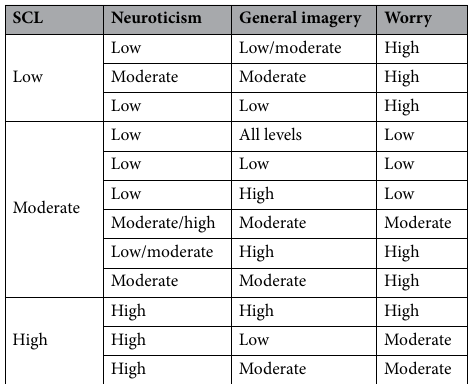
Table 3. Impact matrix of SCL level for possible configuration of the predictors from Model 3.